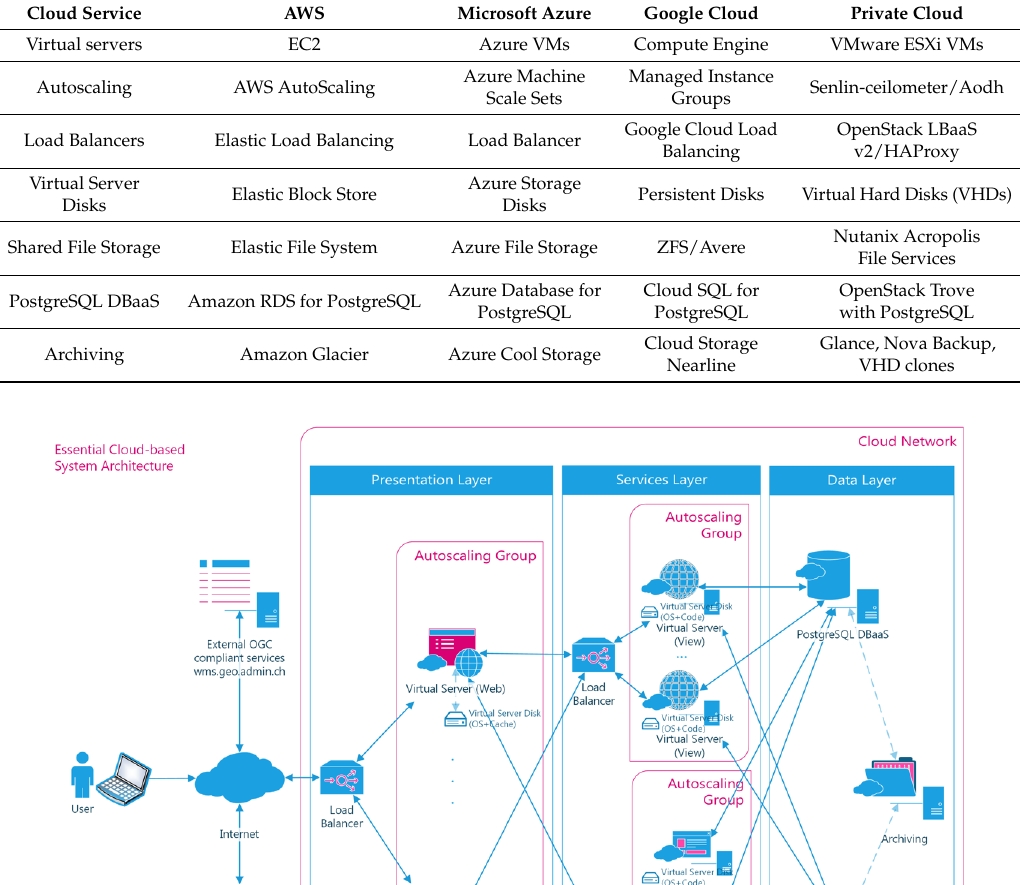
Table 1. Essential Cloud Services for Geoportals.